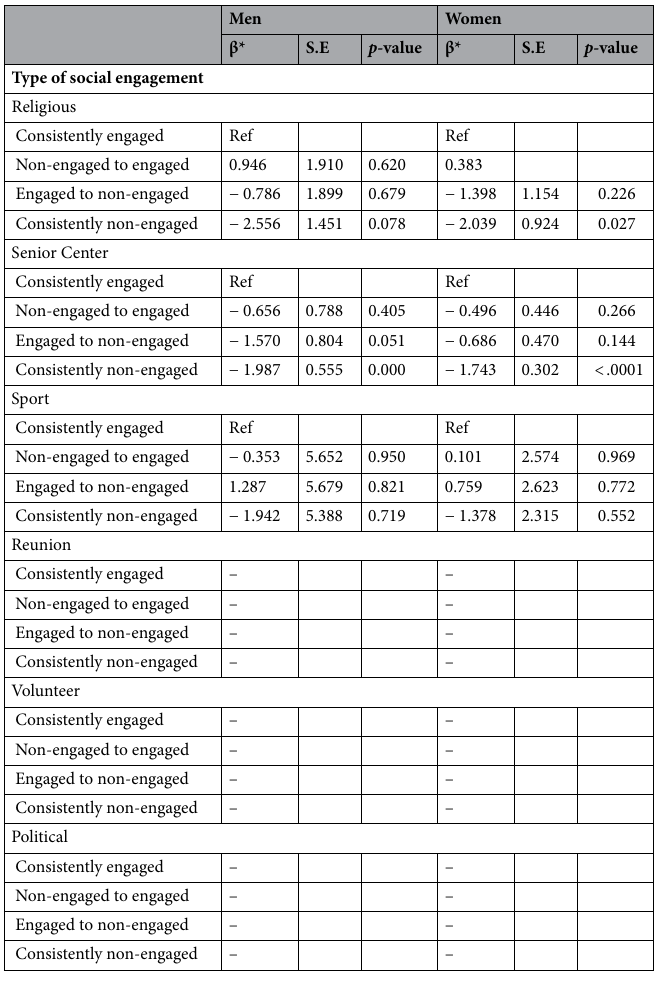
Table 3. Subgroup analysis of association between type of social engagement and cognitive decline measured via